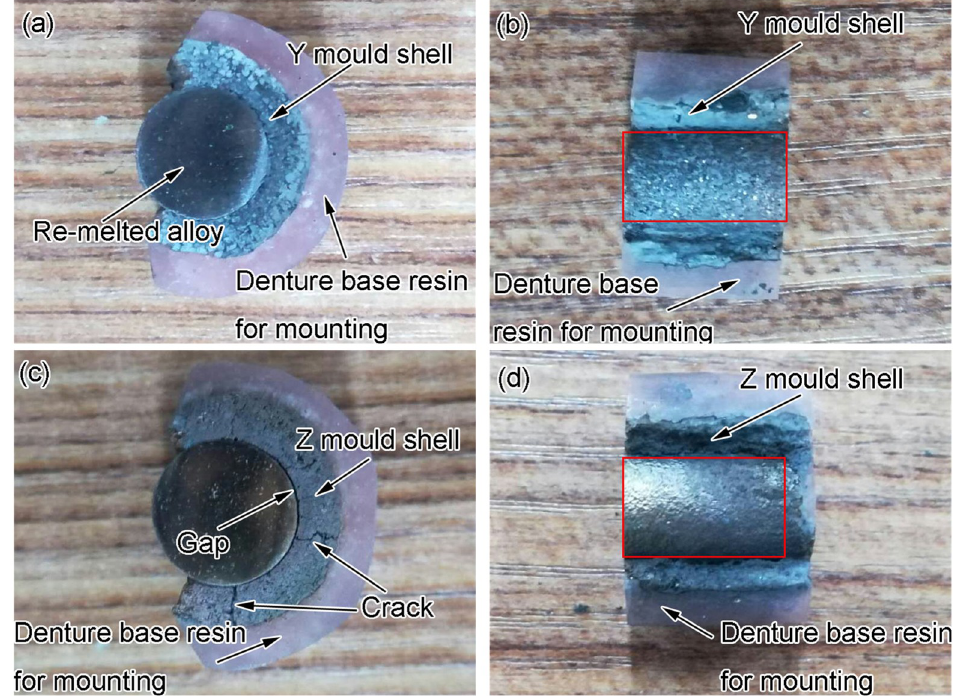
Figure 4. Macromorphologies of the samples after re-melting at 1850 °C for 30 min in a vacuum furnace with a tungsten heating element: ( a ) cross section and ( b ) lateral surface of the re-melted alloy in the Y mold shell; ( c ) cross section and ( d ) lateral surface of the re-melted alloy in the Z mold shell.